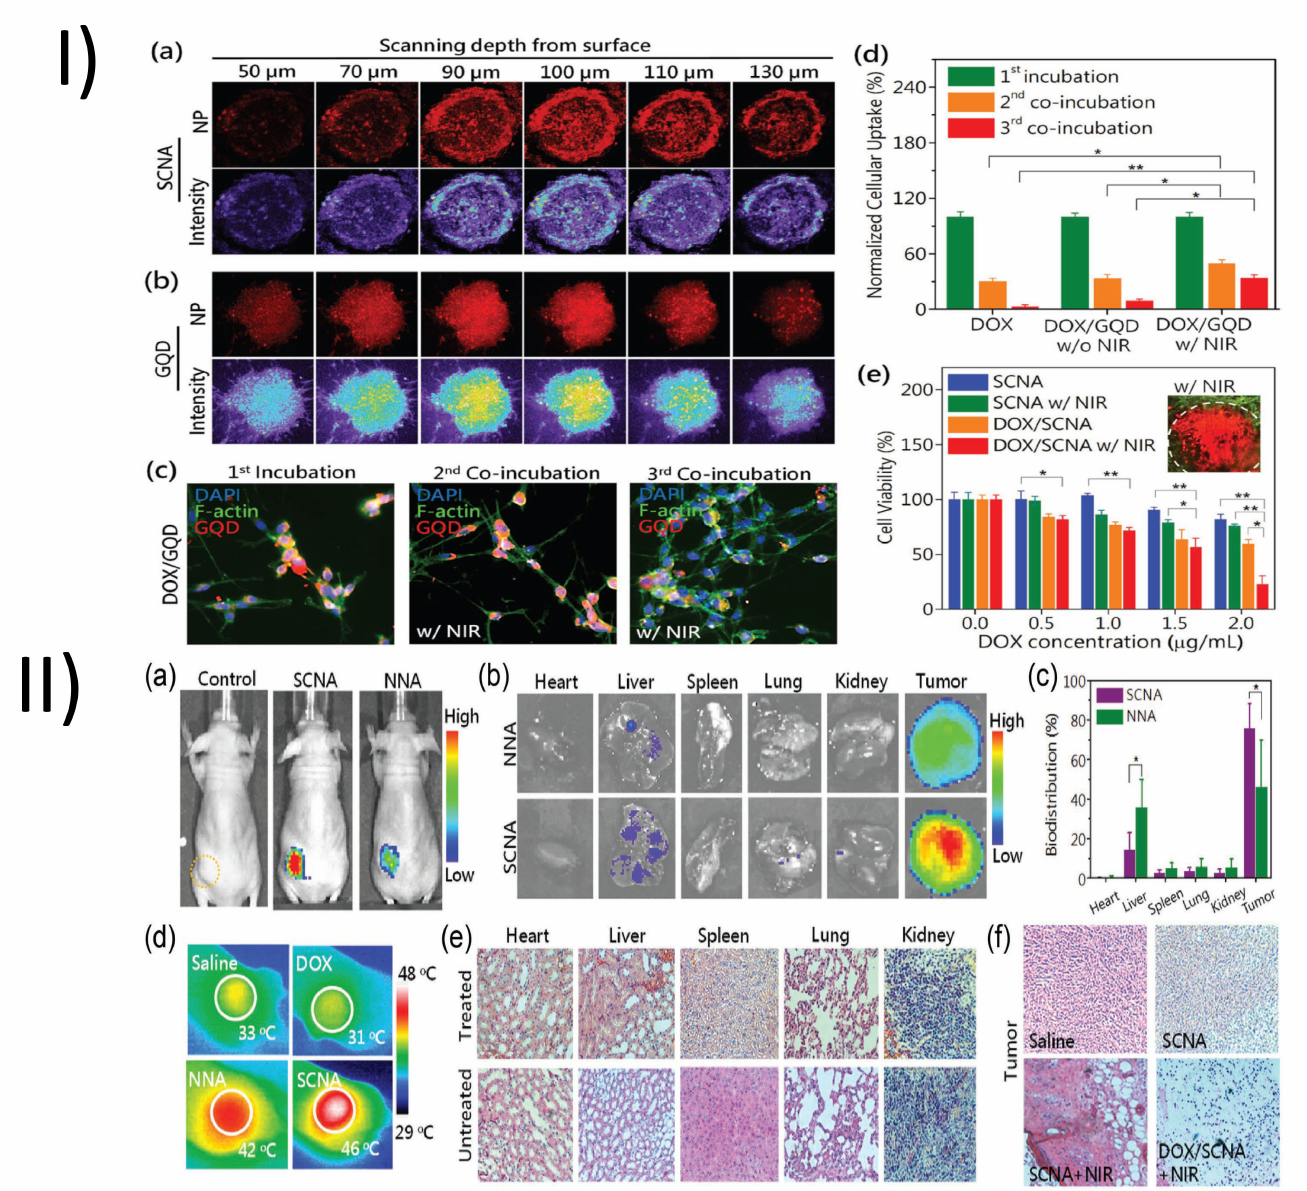
Figure 9. ( I ) ( a , b ) In an ex vivo penetration assay, photographs of fluorescence-labeled SCNAs and GQDs in RG2 multicellular tumor spheroids were used; ( c ) DOX/GQDs doubly coincubated with NIR exhibited a cellular sequence of intercellular delivery; ( d ) Flow cytometry standardizes the amounts of intercellular delivery by dividing by the number of cells and how well they take up the substance after the first incubation; ( e ) The cytotoxicity of SCNA and DOX/SCNA treatments for RG2 cells, with and without 5 min of NIR irradiation, were compared. ( II ) ( a ) IVIS image of tumor-bearing mice; ( b ) Mice tumors and primary organs involved in their clearance, as shown by fluorescence; ( c ) Fluorescence intensity of major organs and tumors; ( d ) Naked mice with RG2 tumors, as seen by thermography; ( e ) Histological examination of major organs in untreated and treated mice; ( f ) H&E tumor staining after photothermal therapy combined with chemotherapy for SCNA showed pore damage and fibrosis. (* Indicate p < 0.05 and ** indicate p < 0.001). Reproduced with permission from Ref. [115], Figures 5 and 6. (Wiley ©